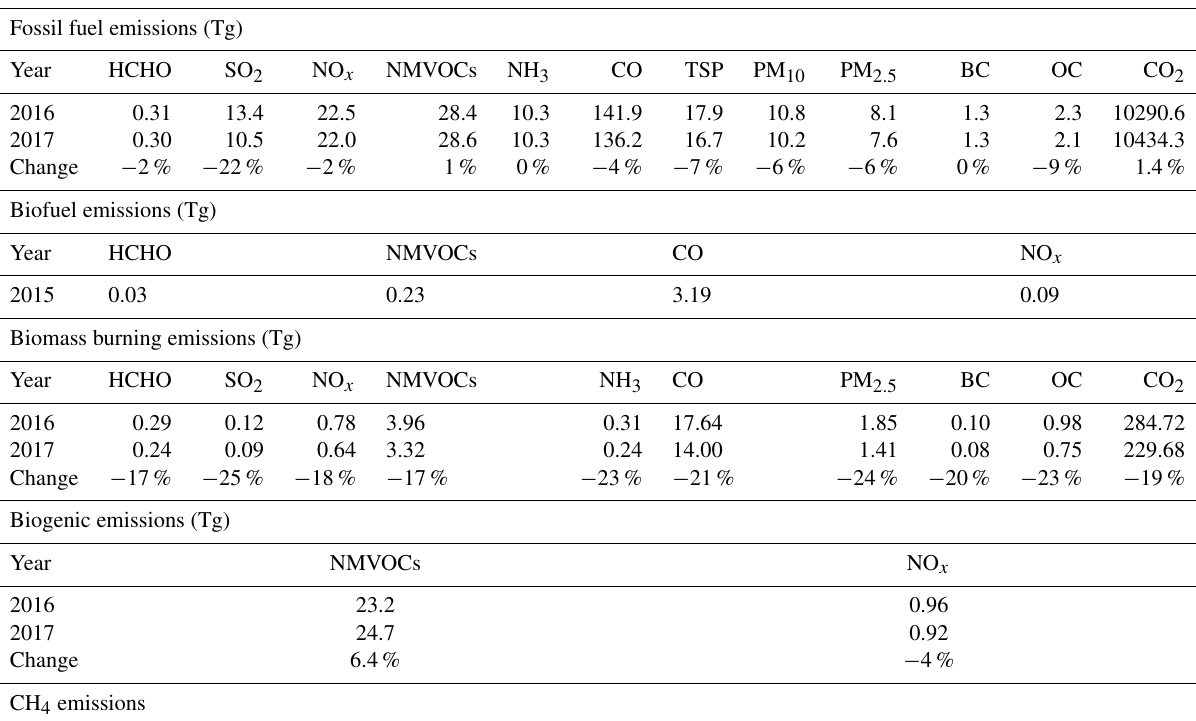
Table 2. Total emissions of all atmospheric compounds over China used in the GEOS-Chem model. Fossil fuel emissions (Tg) Year HCHO SO 2 NO x NMVOCs